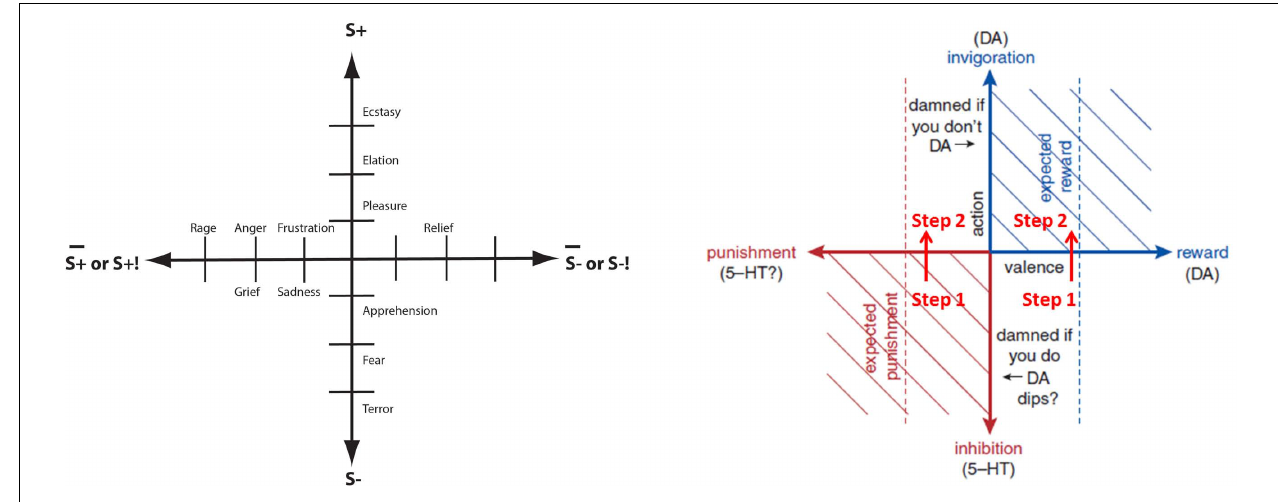
where activation spans outward from the origin (center) and cuts across the diagonals of the four quadrants in the Boureau and Dayan model. In this manner, the upper right quadrant provides the S + dimension, the lower left quadrant the S − dimension, the upper right quadrant the S − omission/termination dimension, the bottom right quadrant the S + omission/termination dimension. Reprinted with permission.